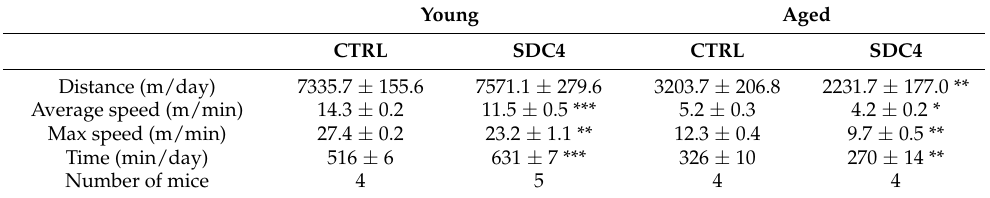
Table 2. Voluntary running